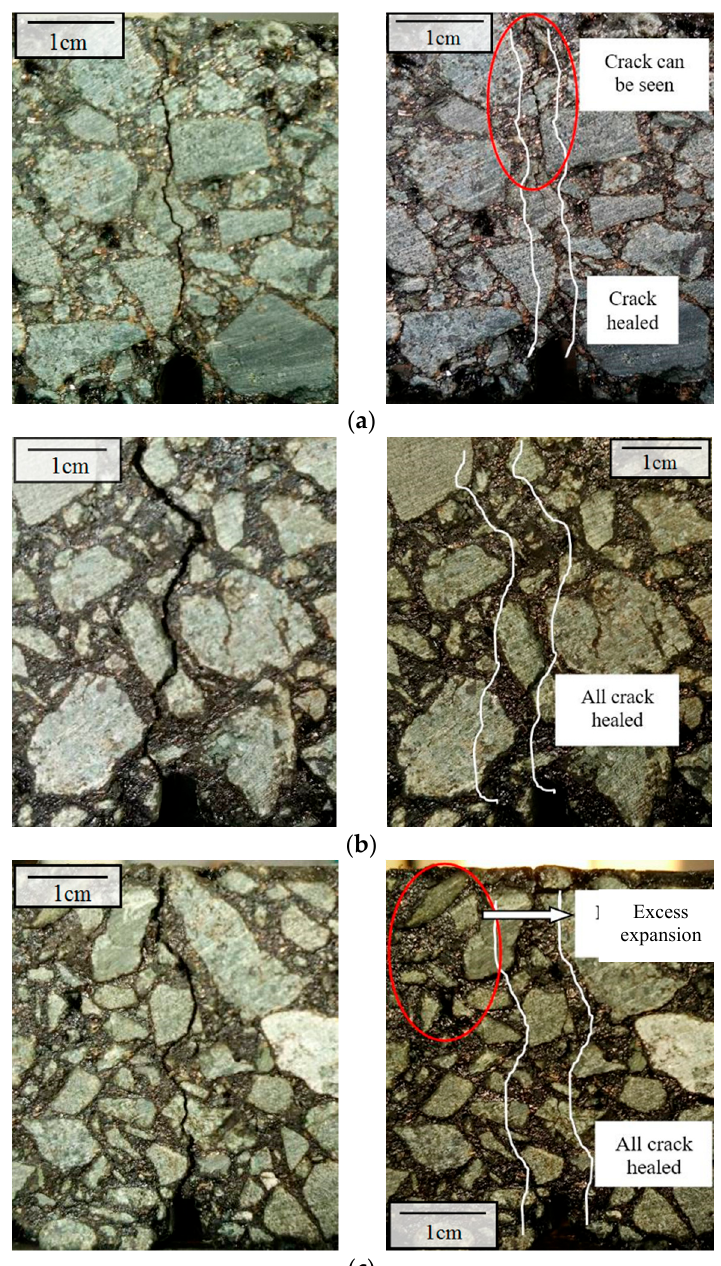
Figure 9. Healing phenomenon of asphalt concrete at different microwave heating temperatures. ( a ) Crack healing phenomenon at 60 °C: partially healed; ( b ) Crack haling phenomenon at 80 °C: fully healed; ( c ) Crack healing phenomenon at 100 °C: fully healed with excess expansion of the binder.